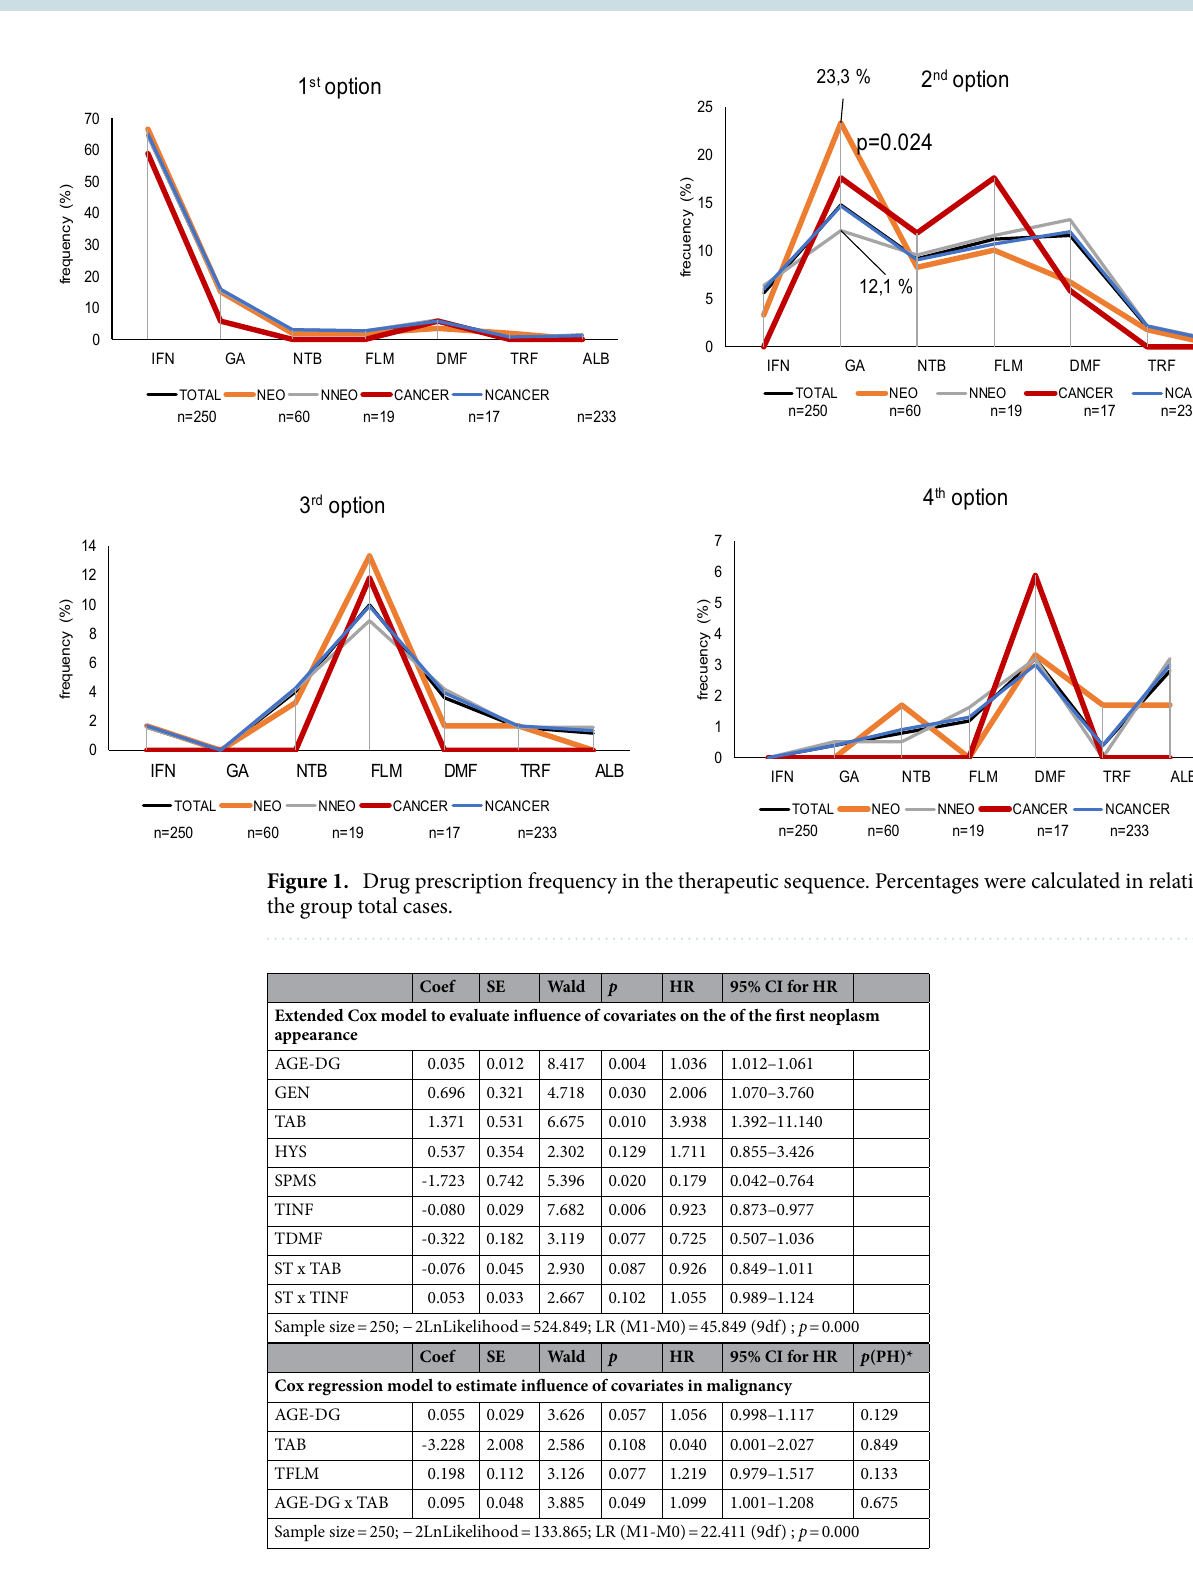
Table 4. Cox analysis to assess the risk of neoplasm development. AGE-DG: age at MD diagnosis; GEN: gender; TAB: smoking; HYS: family history of neoplasm; SPMS: secondary progresive MS phenotype; TINF: time of INF use; TDMF: time of DMF use; TFLM: time of FLM use; ST: survival time (neoplasm-free time). *We have included non-significant p (PH)-values to contrast each covariate.